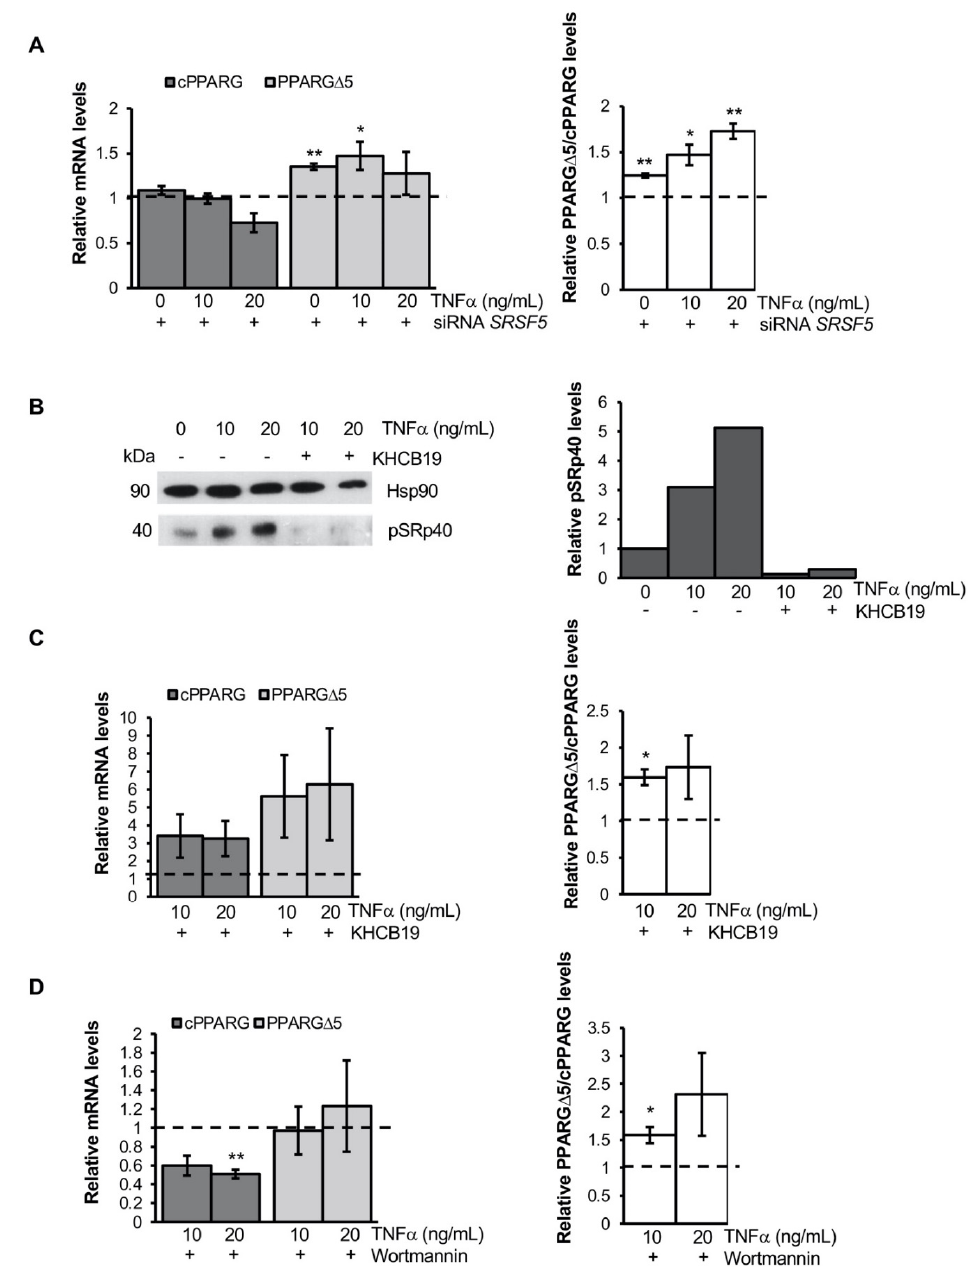
Figure 5. SRp40 is involved in the PPARG splicing modulation induced by TNF α : ( A ) Relative mRNA quantification (qPCR) of cPPARG, PPARG ∆ 5 (left panel) and the PPARG ∆ 5/cPPARG ratio (right panel) in hMSCs at the undifferentiated stage knock out for SRSF5 and treated for 24 h with 0, 10 or 20 ng/mL of human recombinant TNF α cytokine. hMSCs at 0 h transfected scrambled and treated for 24 h with 0, 10 or 20 ng/mL of human recombinant TNF α cytokine were used as reference samples (dotted lines). PPIA was used as the reference gene. Data are reported as mean ± SEM of at least three independent experiments. * p ≤ 0.05 and ** p ≤ 0.01. ( B ) Western blot of SRp40 phosphorylation (i.e., pSRp40; left panel) levels in hMSCs at T = 0 h treated with wortmannin or vehicle (i.e., DMSO) in combination and not with 10 or 20 ng/mL of TNF α cytokine. Hsp90 was used as loading control. Bar graphs (right panel) report relative pSRp40 levels normalized on Hsp90 expression (pixel density analysis of Western blot). ( C ) Relative mRNA quantification (qPCR) of cPPARG, PPARG ∆ 5 (left